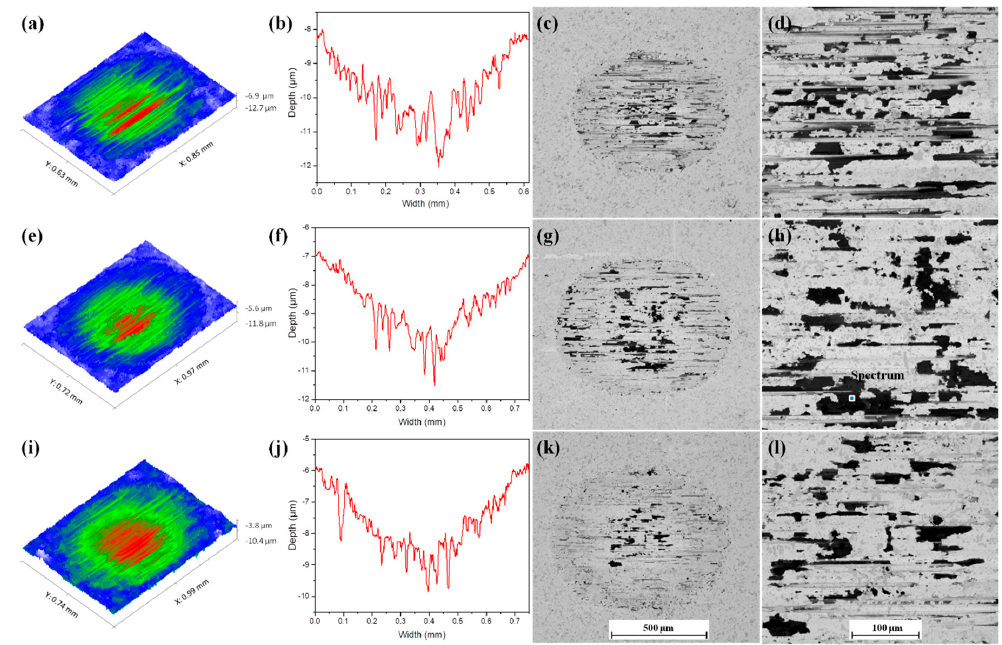
Figure 7. 3D surface morphologies, cross-sectional profiles and scanning electron microscopy using backscattered electron mode (SEM-BSE) images of the wear scars after fretting cycles of 24 × 10 3 ( a – d ), 48 × 10 3 ( e – h ) and 72 × 10 3 ( i – l ) under the normal load of 35 N.